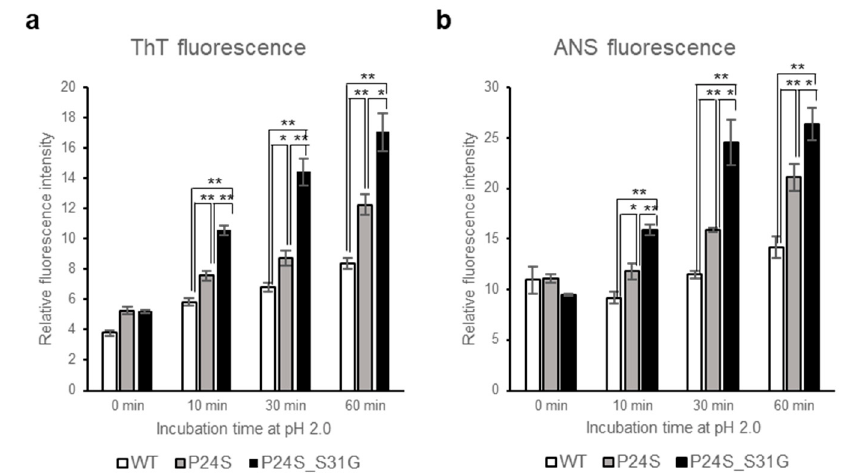
Figure 5. Effect of P24S/S31G double mutations on the fibril formation and tertiary structure of γ D-crystallin in acidic pH. ( a ) ThioflavinT fluorescence emission intensity measurement ( λ Ex = 440 nm, λ = 485 nm) of WT, P24S, and P24S / S31G mutant γ D-crystallin as a function of incubation time. Samples were incubated at pH 2.0 for indicated time. ( b ) ANS fluorescence intensity measurement of WT, P24S and P24S / S31G mutant γ D-crystallin. ANS fluorescence emission intensity of γ D-crystallin sample as a function of incubation time are represented with WT (white bar), the P24S mutant (gray bar) and the P24S / S31G mutant (black bar). The final concentration was 0.04 mg / mL. Data points are presented as the means ± standard deviations (S.D.) of at least 3 independent measurements in each Figure. * p < 0.05; ** p < 0.01 versus